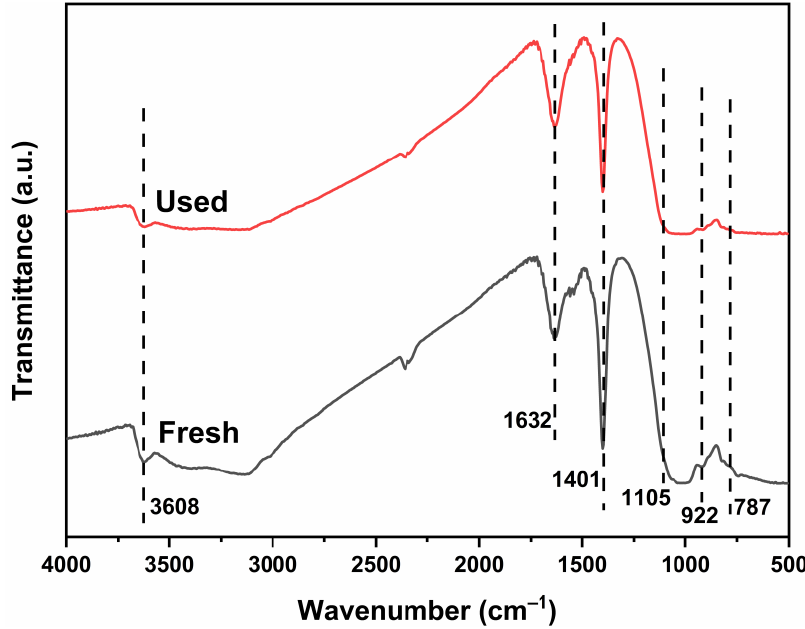
Figure 12. FTIR spectra of 1-ATM photocatalyst before and after the photocatalytic experiment.